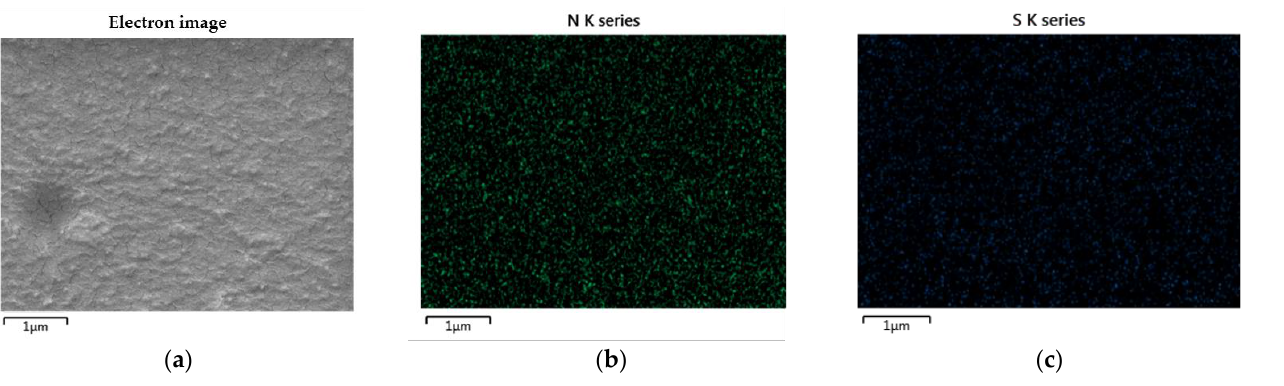
Figure 3. Scanning electron microscope (SEM) images and EDS elemental mapping images: ( a ) elec- tron image; ( b ) nitrogen and ( c ) sulfur distribution in PEDOT:PSS/nonionic WPU (WPU 2.0 wt%) on TPU film.